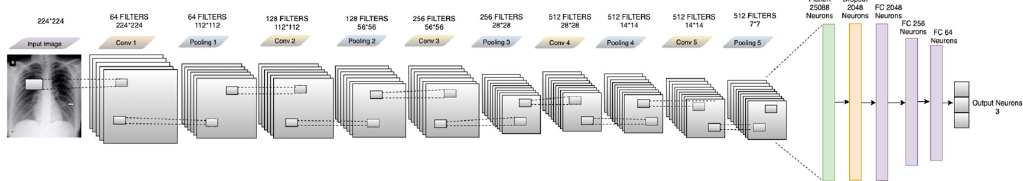
Fig 4. Feature extraction of the input image is performed via the convolution, ReLU and pooling layers, before classification by the fully connected layer.